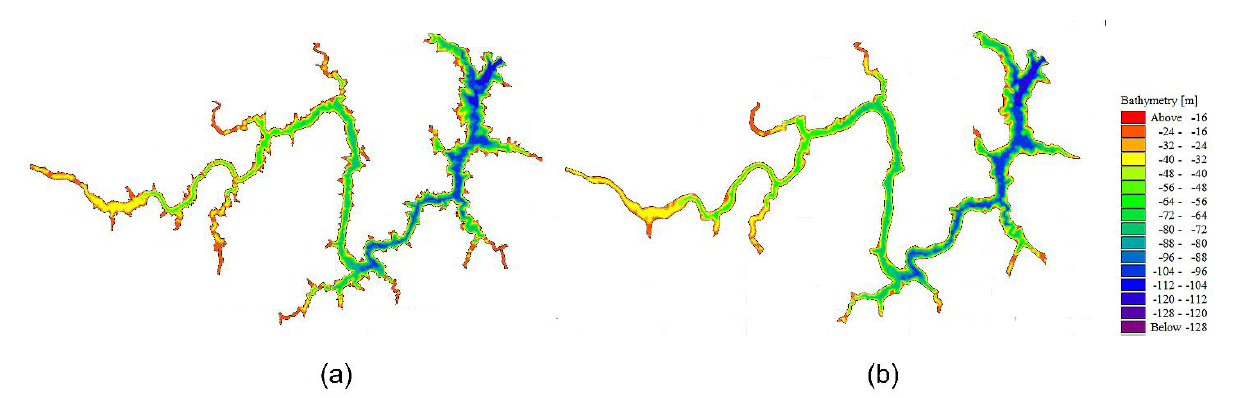
Figure 2. Smoothing on the edge of the calculated region: ( a ) before smoothing, ( b ) after smoothing.